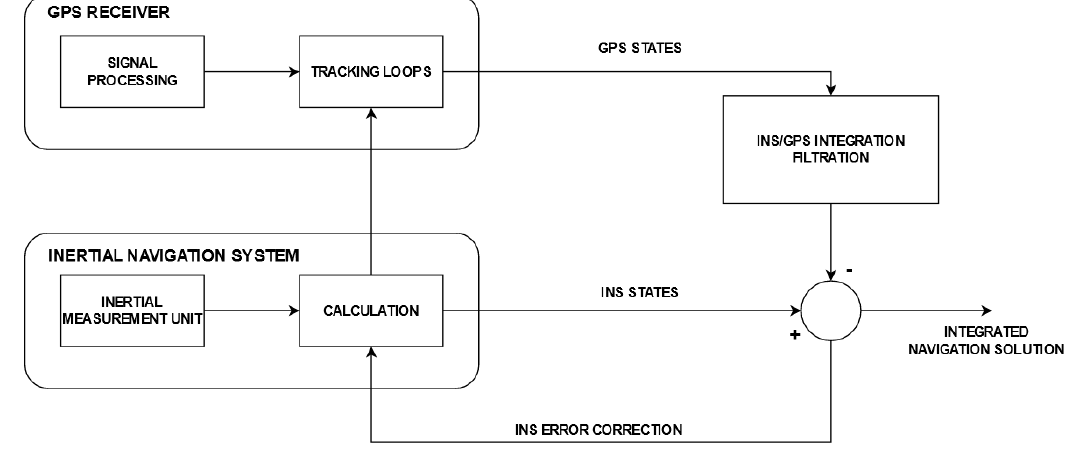
Figure 3. Conceptual design of the integrated navigation system with INS and GPS